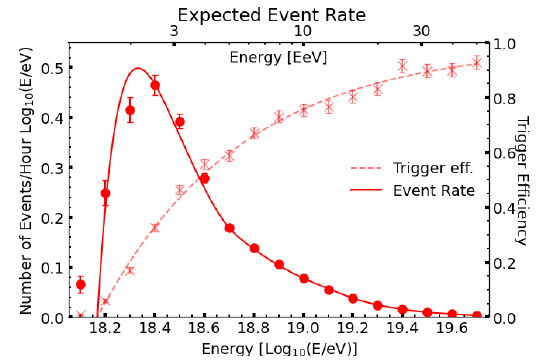
Figure 5: Expected event rate of the FT.